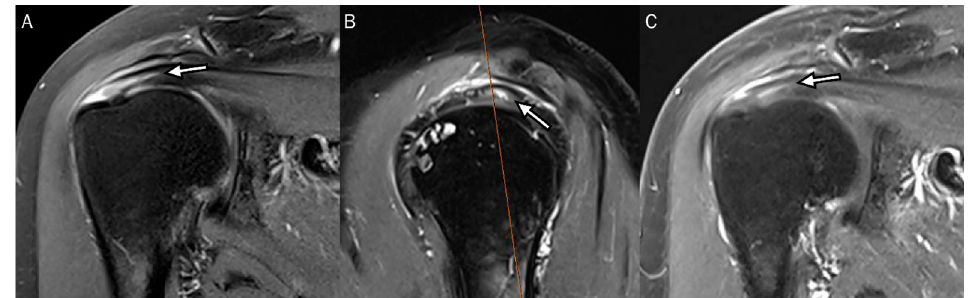
Figure 4. Enhancement of the synovial intraarticular tissue at the delaminated tear. ( A ) Oblique coronal fat-suppressed T2-weighted image and ( B ) coronal fat-suppressed T2-weighted image demon- strate the articular-delaminated full-thickness tear of the supraspinatus tendon with a visible cleavage (arrow). ( C ) The oblique coronal fat-suppressed T1-weighted enhanced image shows the synovial enhancement at the delamination (arrow).